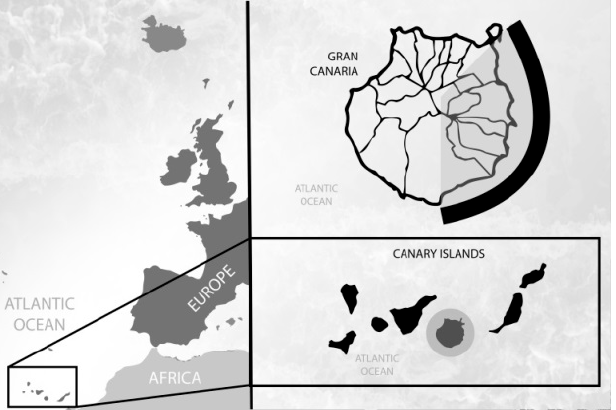
Figure 1. Location of the area where the studied facilities are situated.